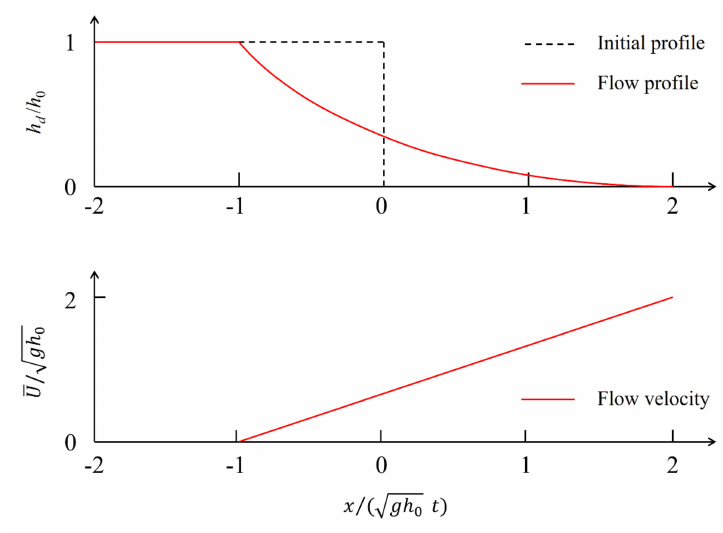
Figure 11. Diagrammatic sketch of Ritter’s